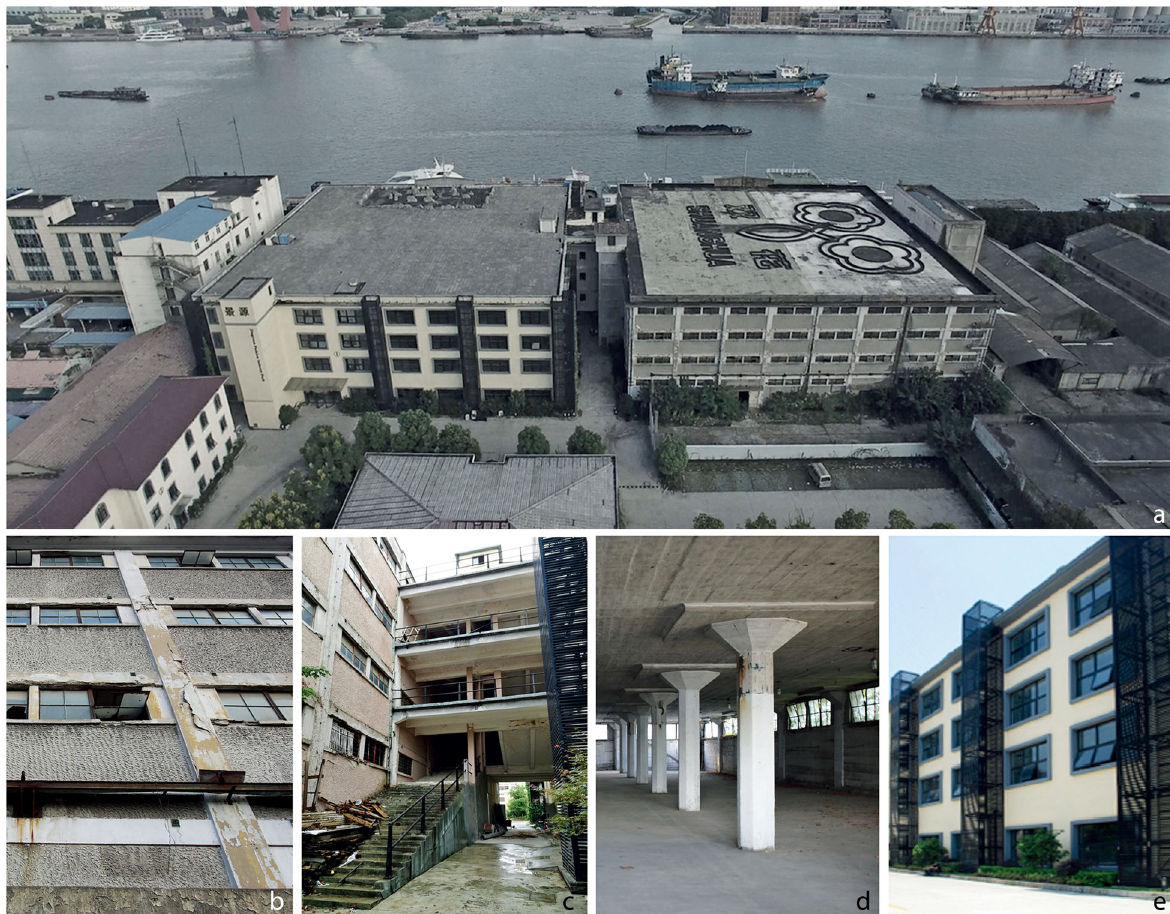
Fig. 6 Yong ’ an Warehouse before the renovation. a: aerial view of the site. b: destroyed exterior walls. c: the connection between the east and west wings. d: interior space. e: renovated eastern warehouse: office building (Source: Archi-Union